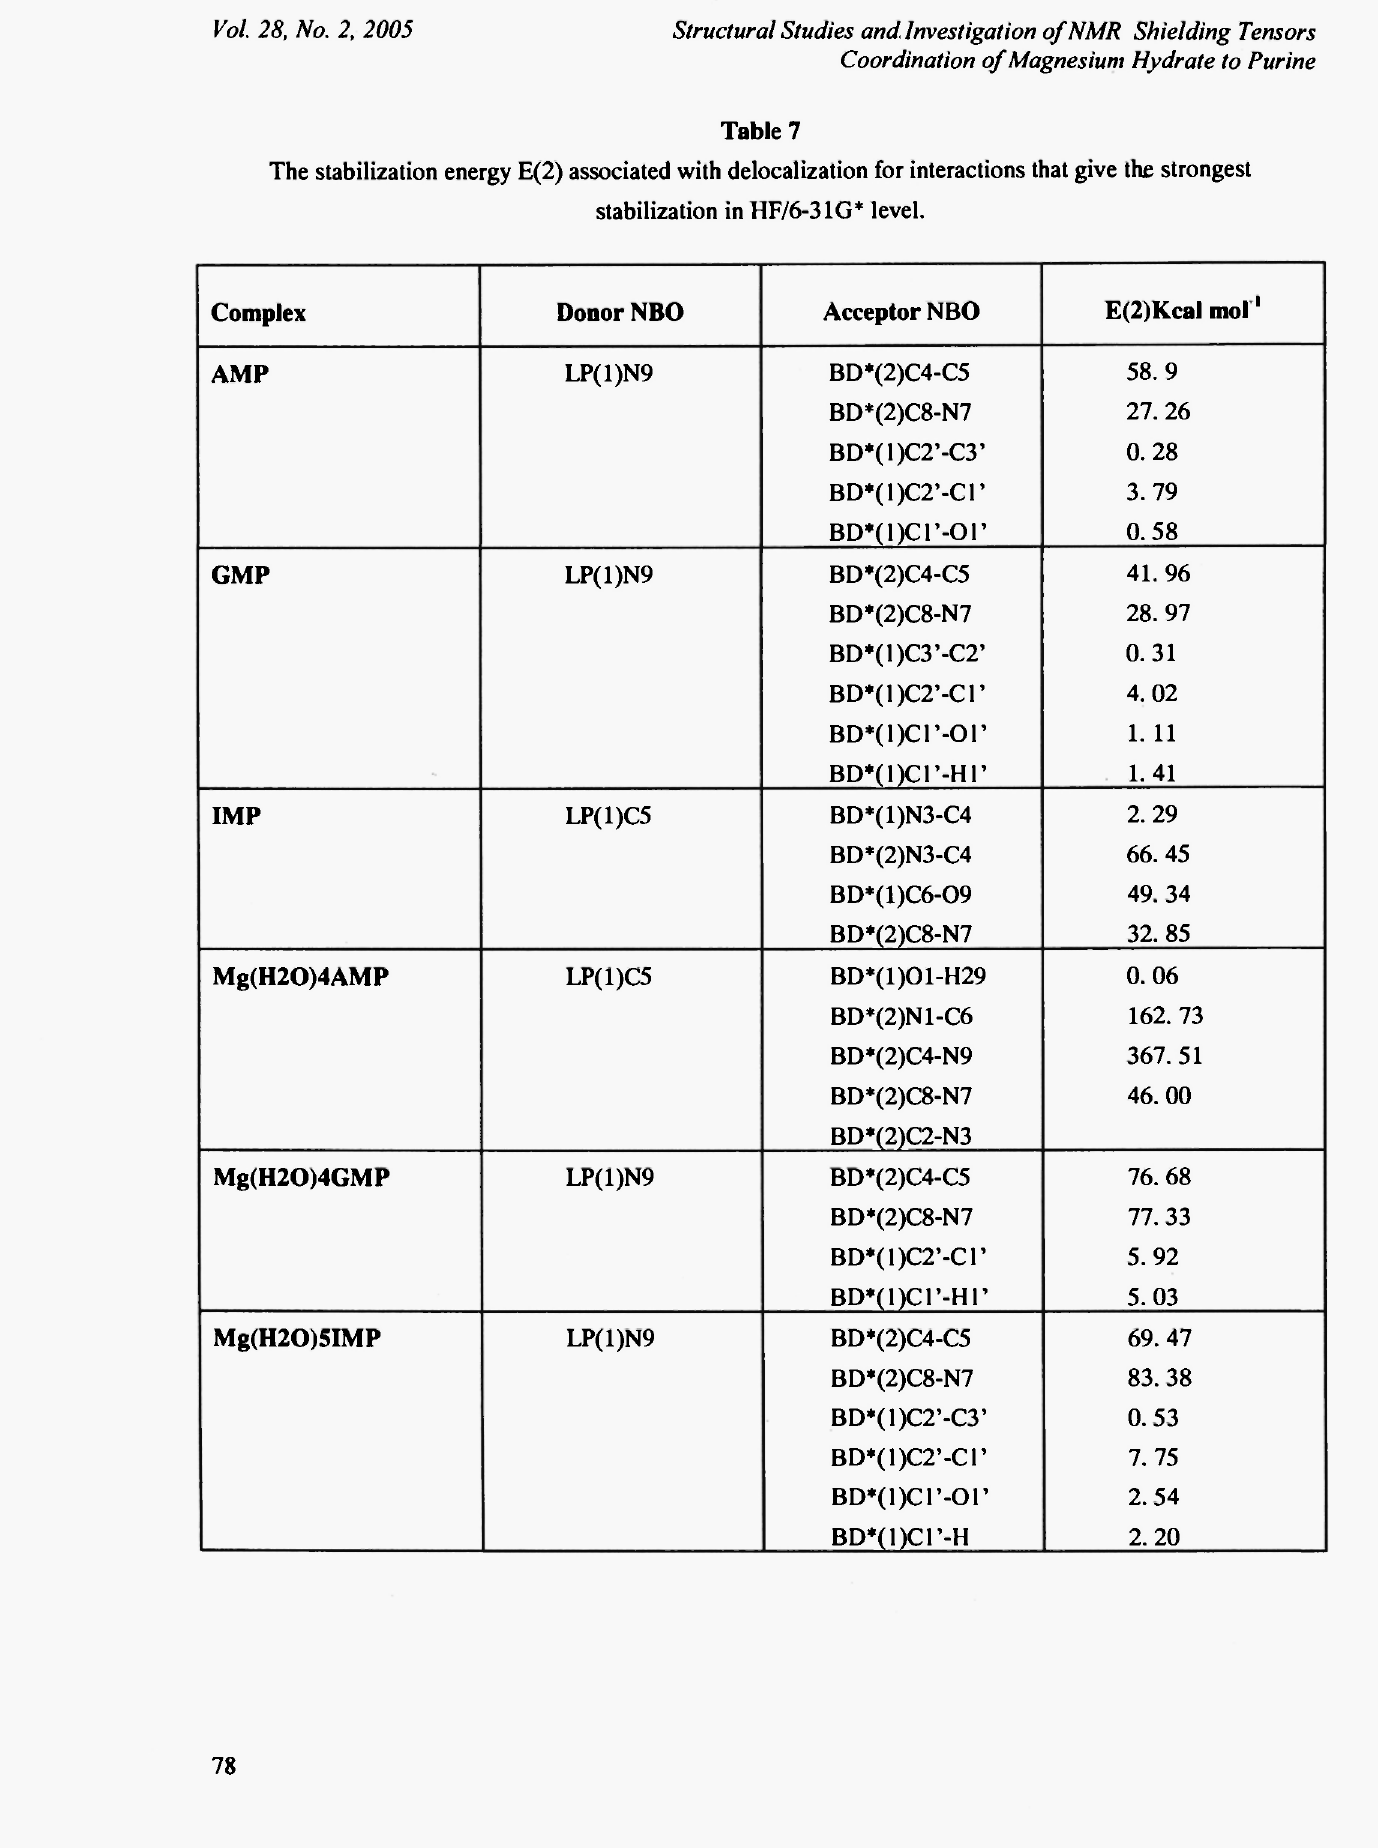
The stabilization energy E(2) associated with derealization for interactions that give the strongest stabilization in HF/6-31G*